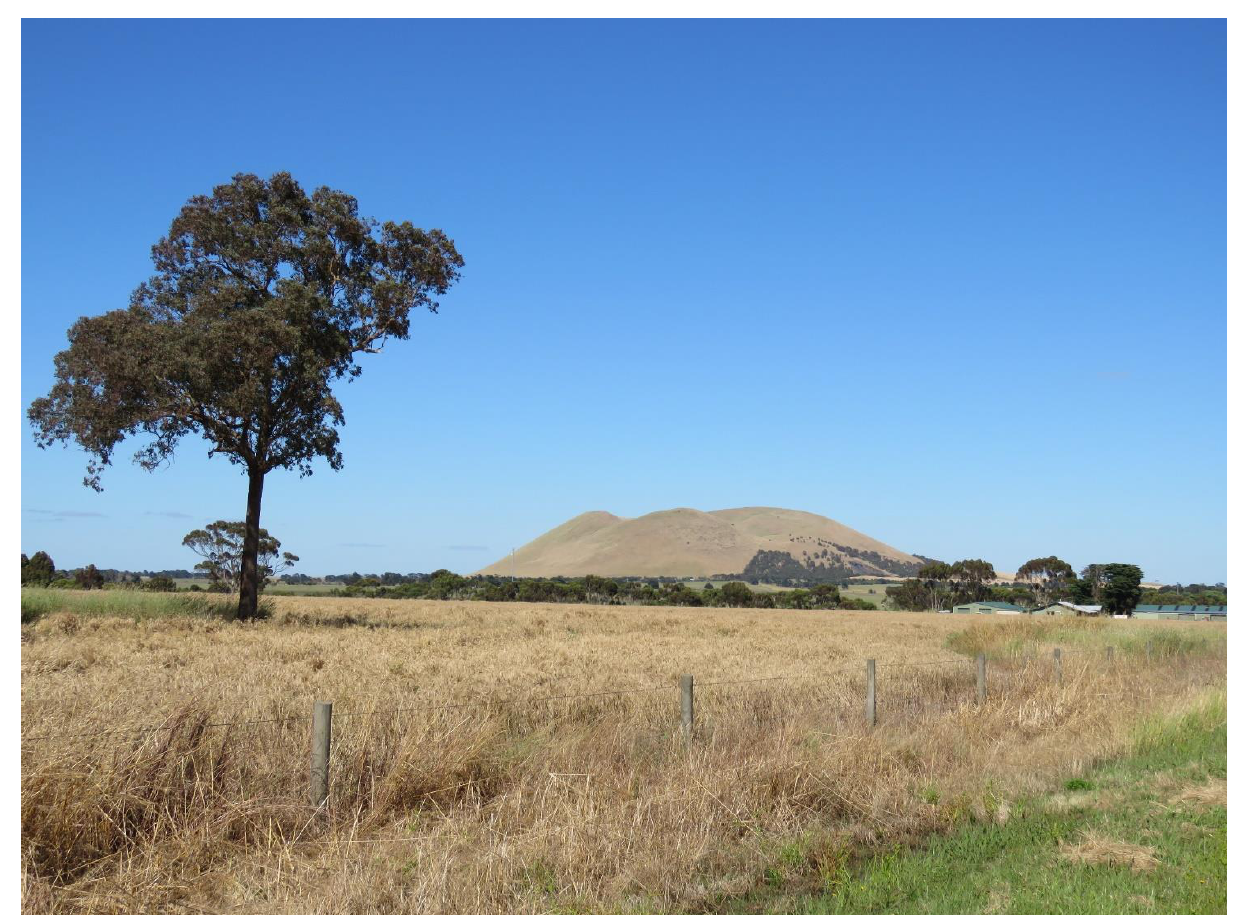
Figure 1. Terrinalum/Mount Elephant. Source: author.